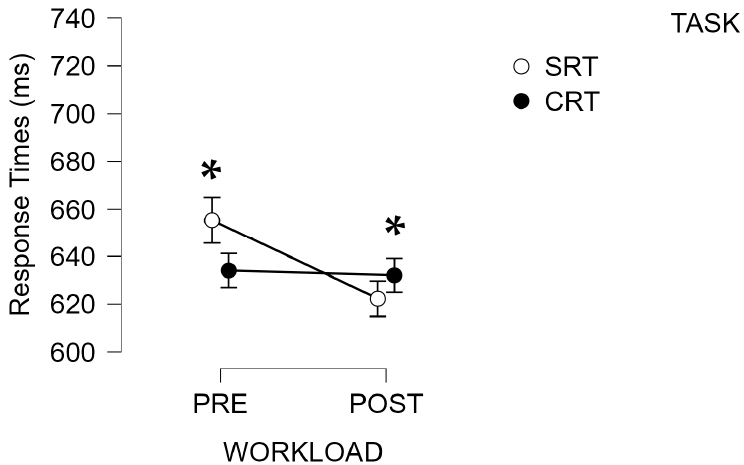
Figure 2. Response times (ms) during simple response time (SRT) and choice response time (CRT) tasks, before (PRE) and after (POST) the workload. * represents significant difference at p < 0.05, and bars represent standard errors.